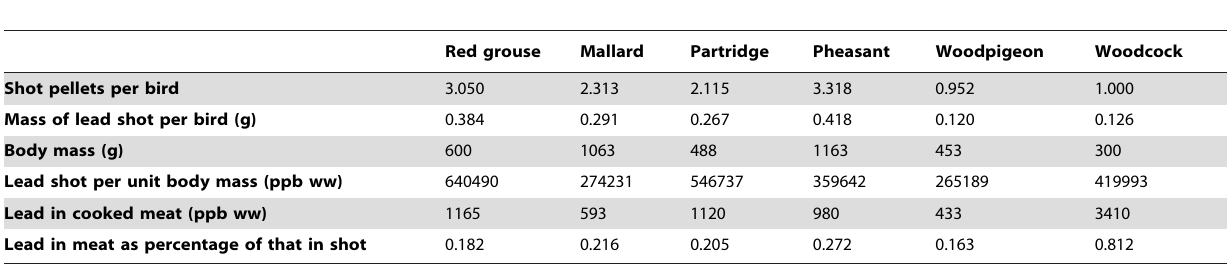
Table 6. The mass of lead in small fragments within the body of a gamebird as a percentage of the mass of gunshot that entered the